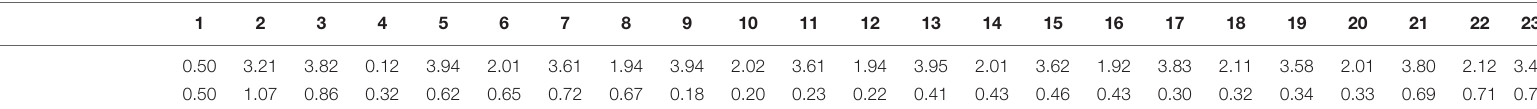
TABLE 1 | Bivariate correlations and descriptive statistics of the variables.